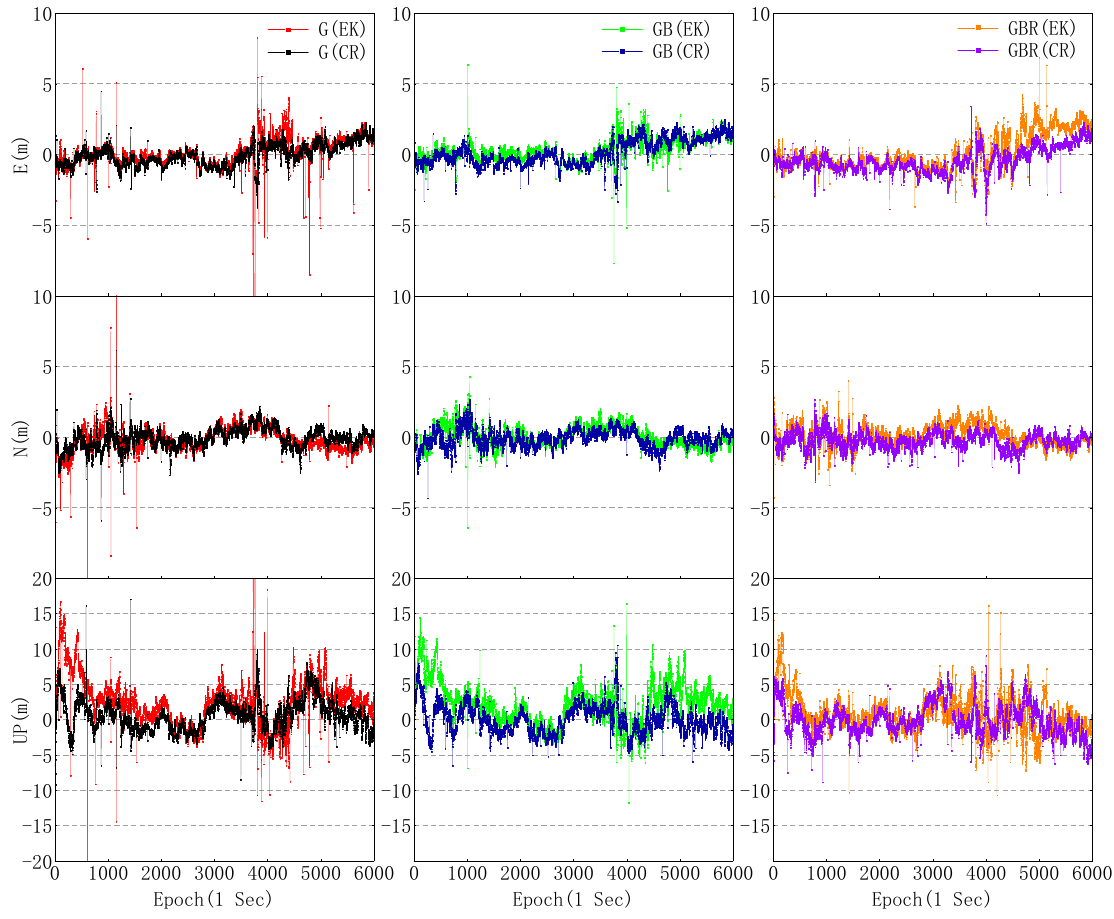
Figure 8. Comparison of the kinematic PPP errors between the conventional and the proposed models with respect to three combinations of GPS, BDS, and GLONASS.